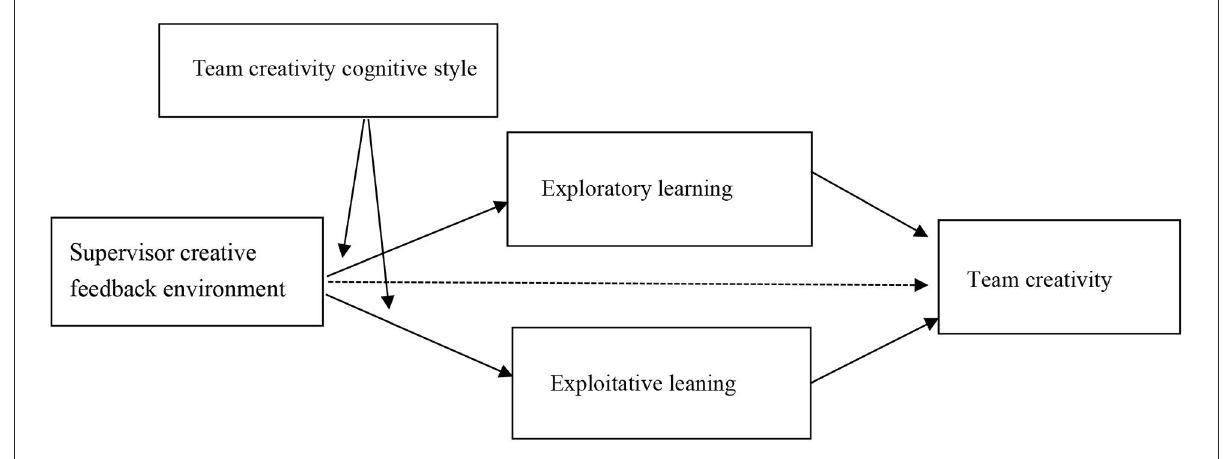
FIGURE1 Research